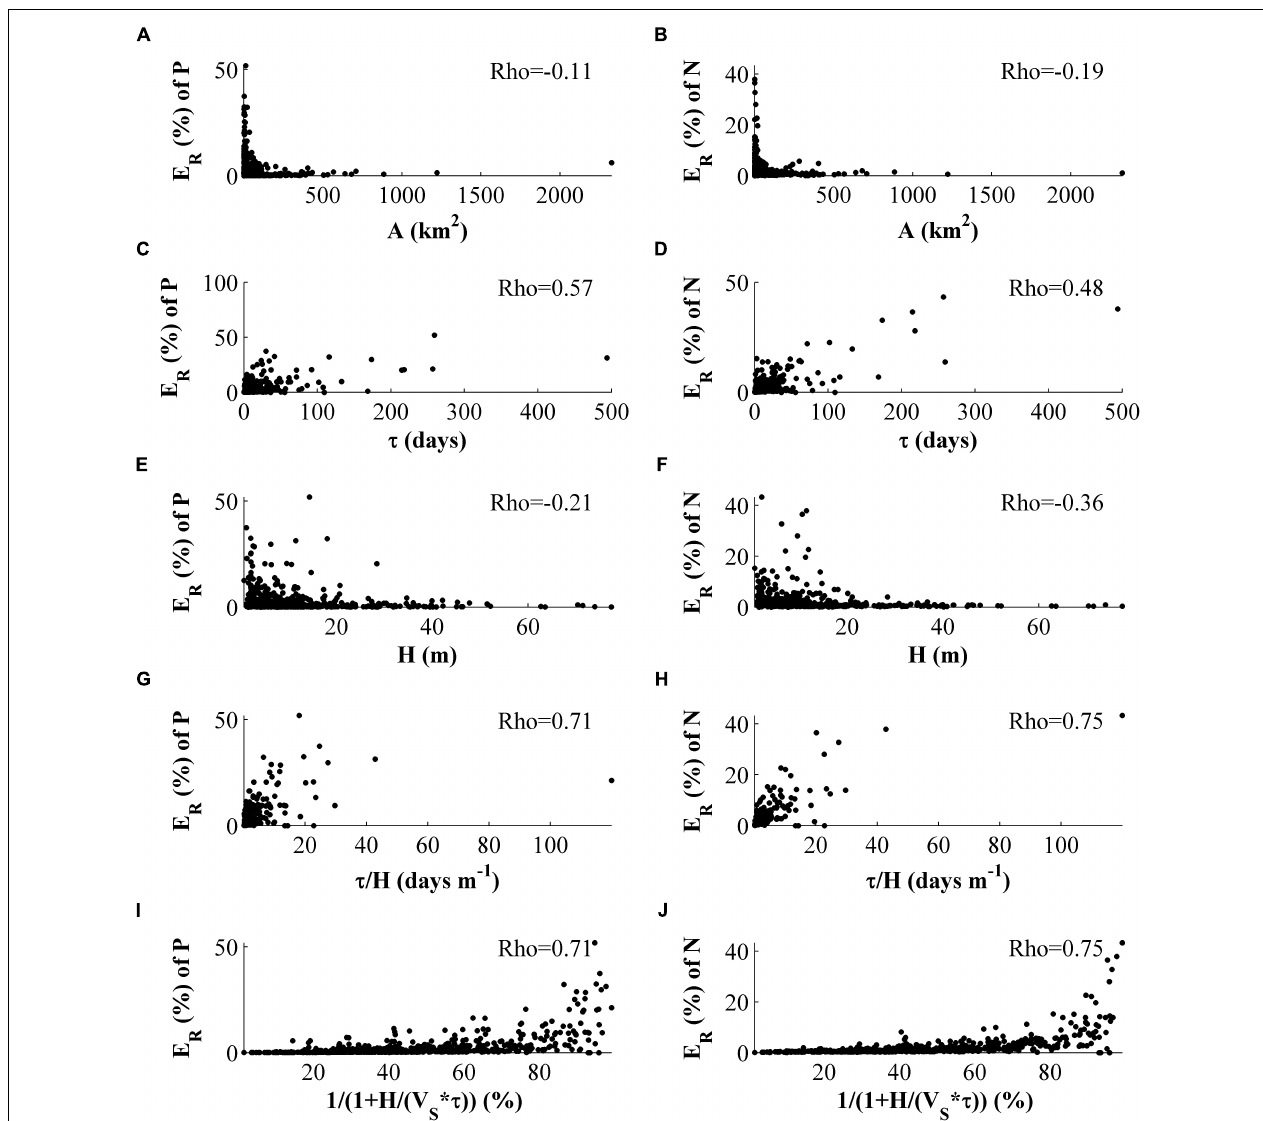
FIGURE 9 | Association of E R ( PNR in percent of total load per area) with physical characteristics of the basins, i.e., surface area ( A ) (A,B) , residence time ( τ ) (E,F) and mean depth ( H ) (C,D) , in different formulations (G,H,I,J) . V S is set to 1. Only statistically significant ( p < 0.05) Rho values are printed in the